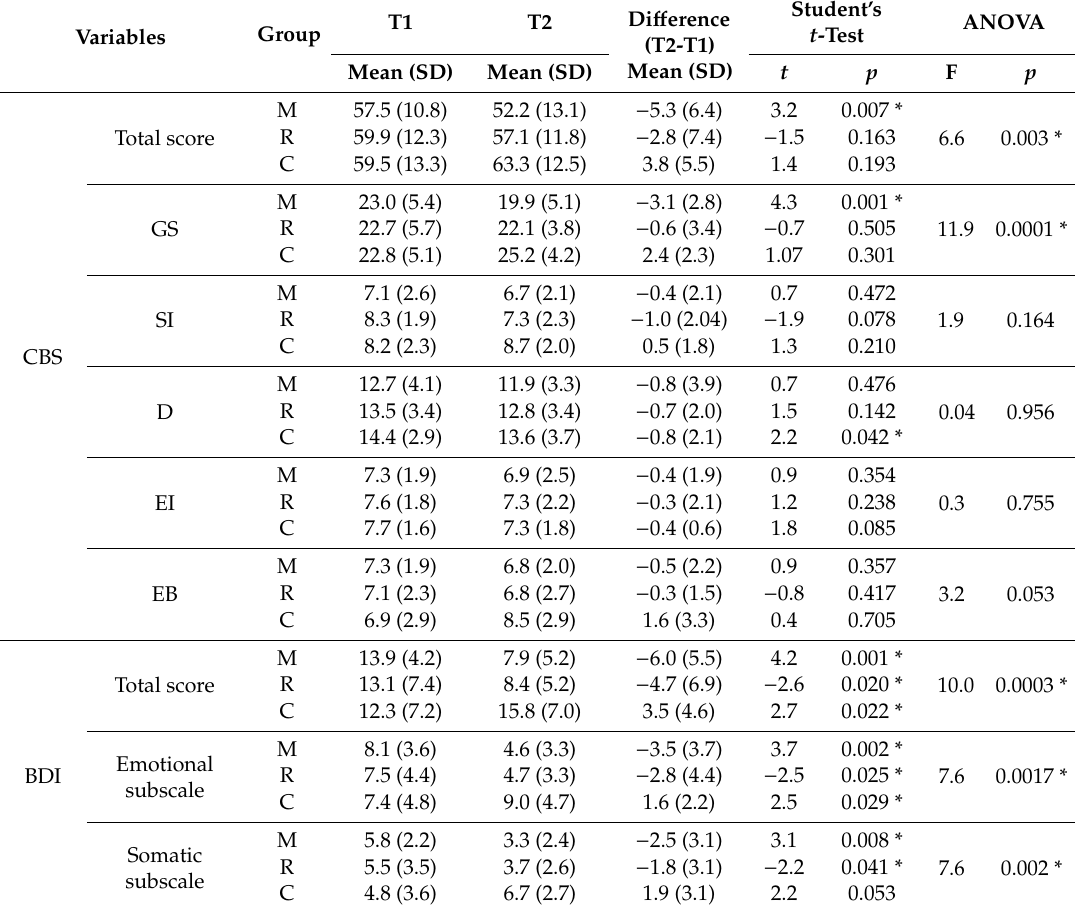
Table 2. Di ff erences in the studied parameters (CBS and BDI) over time (Student’s t -test for dependent groups) and comparisons between the three groups (ANOVA).